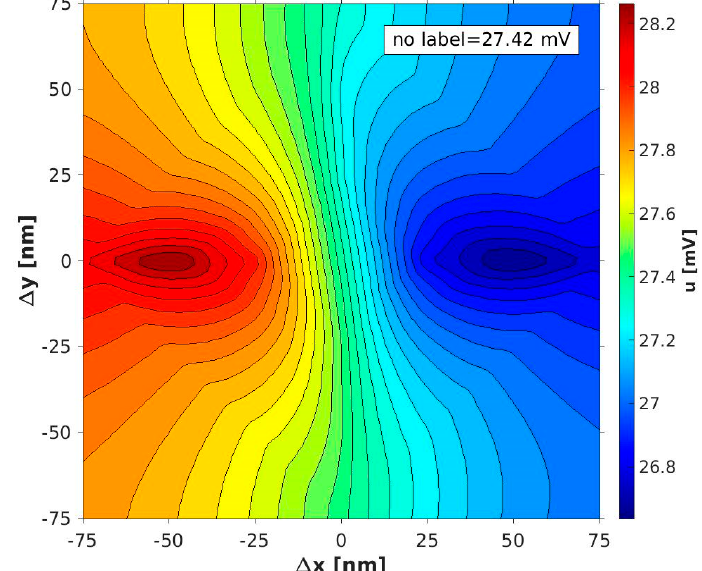
Figure 10. Interpolated electric potential within the x / y plane for a label with a diameter of d = 100 nm at a height of ∆ z = 10 nm. The change in the electric potential reaches its maximum for label shifts parallel to the pinning of the fixed layer.